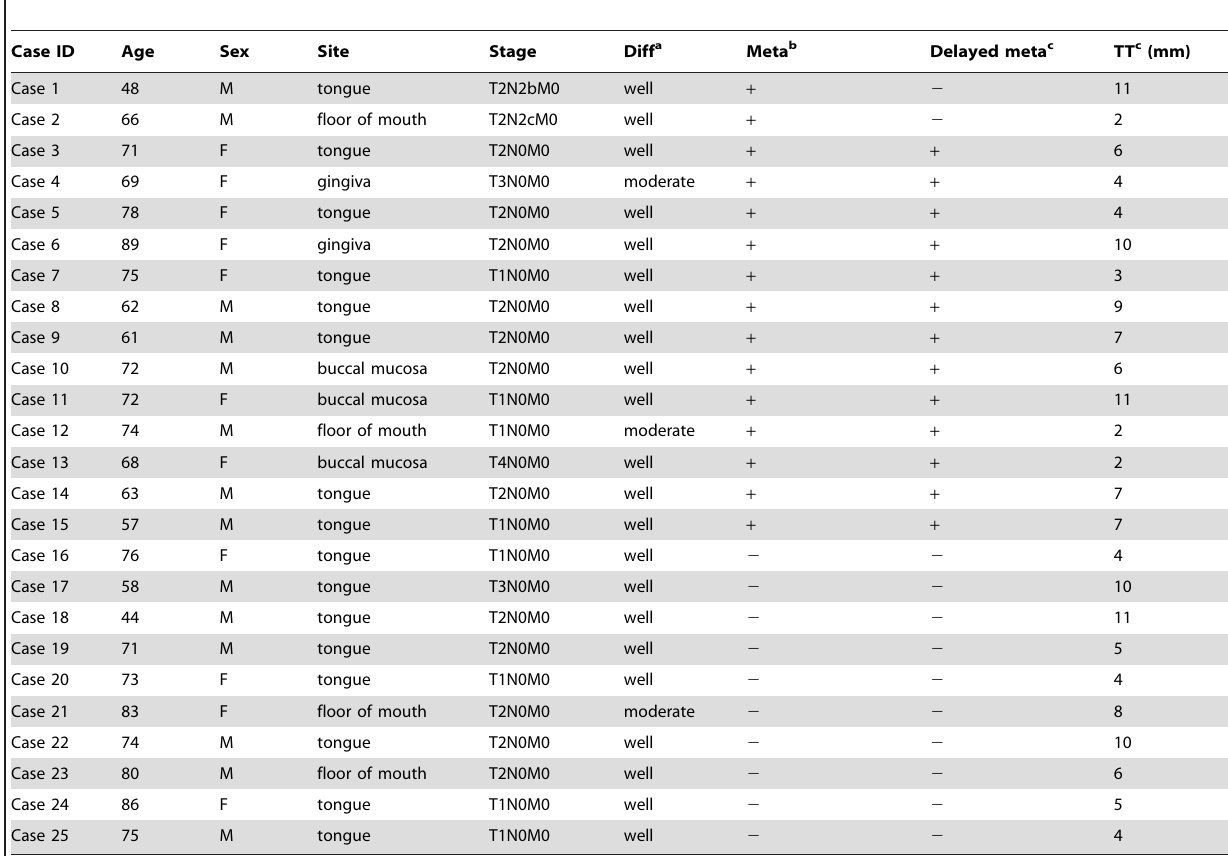
Table 1. Clinicopathological characteristics of the